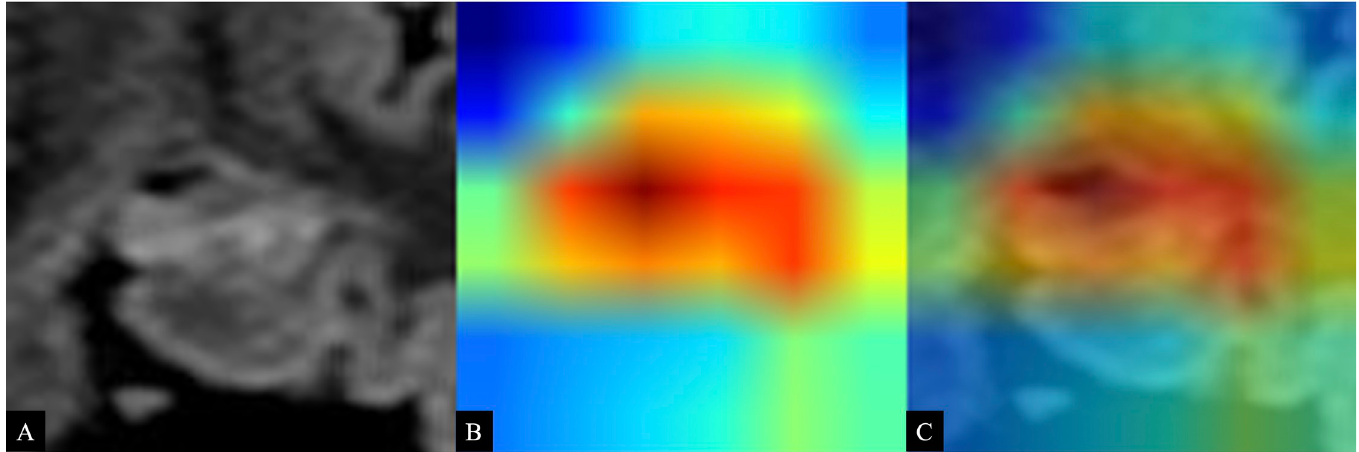
Fig 5. Visualization of the area of interest by deep learning. FLAIR image of a patient with MTLE with the left hippocampus as the epileptogenic area showing abnormal hyperintensity and atrophy (A). Visualization with color mapping using Grad-CAM technique (B) and fusion (C); areas of interest and “hot areas” crowded together surrounding the hippocampus and parahippocampal